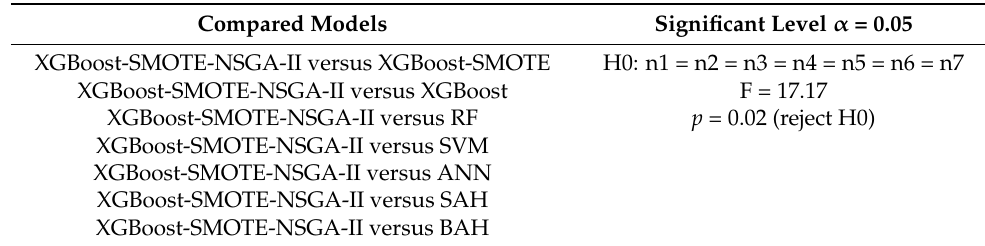
Table 7. Friedman test results on the accumulated return results for XGBoost-SMOTE-NSGA-II against the benchmark methods.